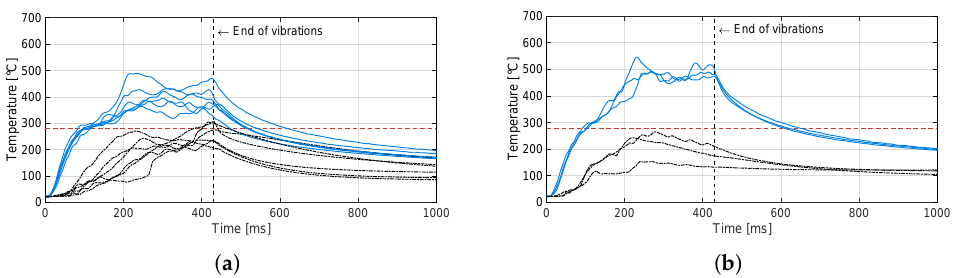
Figure 9. Temperature evolution for the static welding process at the weld interface (blue curves) and through the thickness (black curves) for ( a ) the top adherend and ( b ) the bottom adherend. The temperature evolution at the weld interface in ( a ) is the same as Figure 7a. The red dashed line indicates the melting temperature of PPS ( T m , 280 ◦ C) as experimentally determined by DSC analysis.